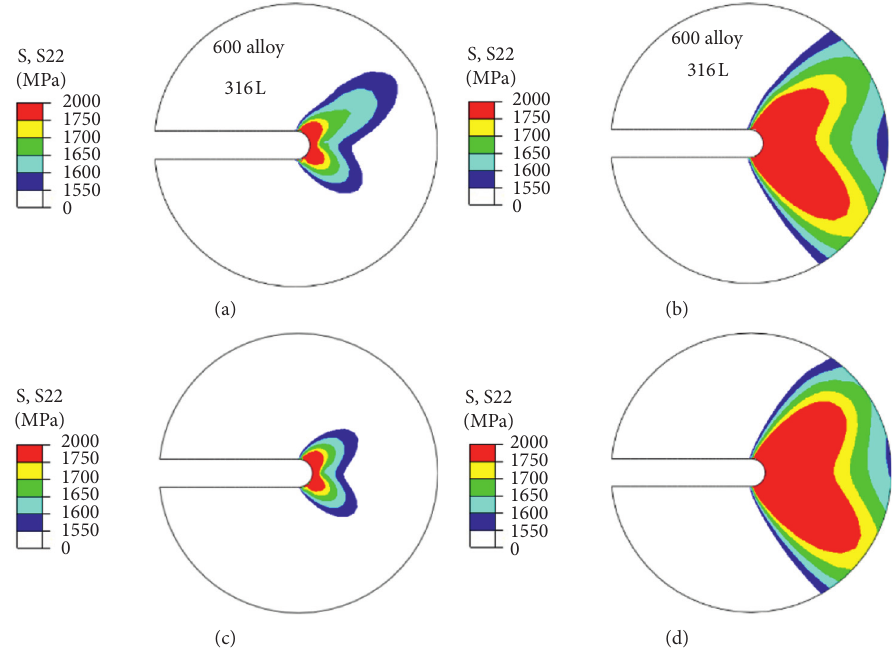
Figure 5: Effect of cold working on tensile stress at different distances from the fusion line. (a) d � 5 μ m, 316L-CW0. (b) d � 5 μ m, 316L- CW10. (c) d � 15 μ m, 316L-CW0. (d) d � 15 μ m,